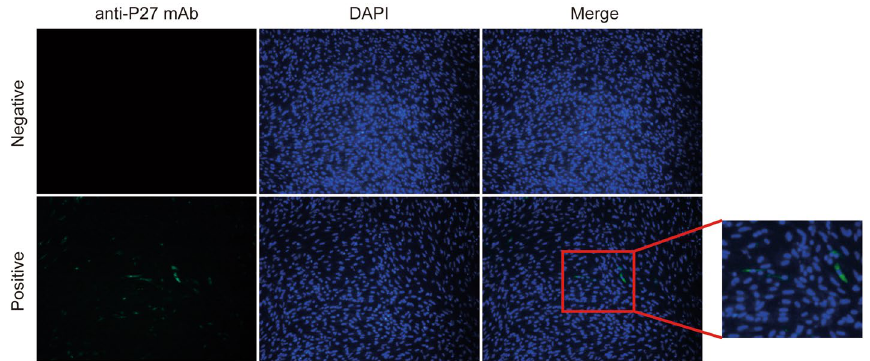
Figure 2. IFA recognizes ALV infection in incubated cells. At 7 days after incubation, the cells were fixed and an IFA was performed with a mAb against P27. DAPI were used to stain the nucleus.